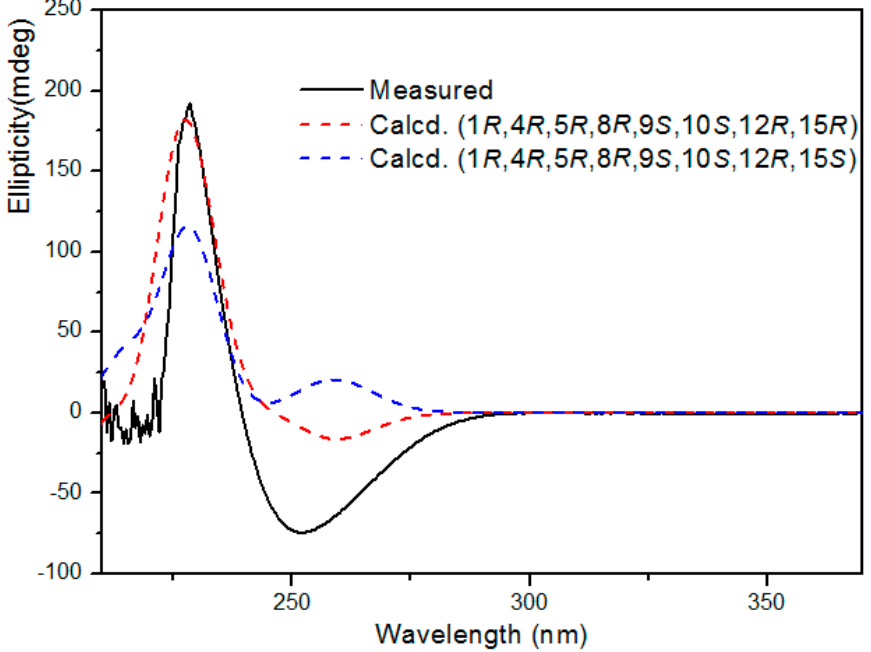
Figure 3. Experimental and calculated ECD spectra of compound 1 .